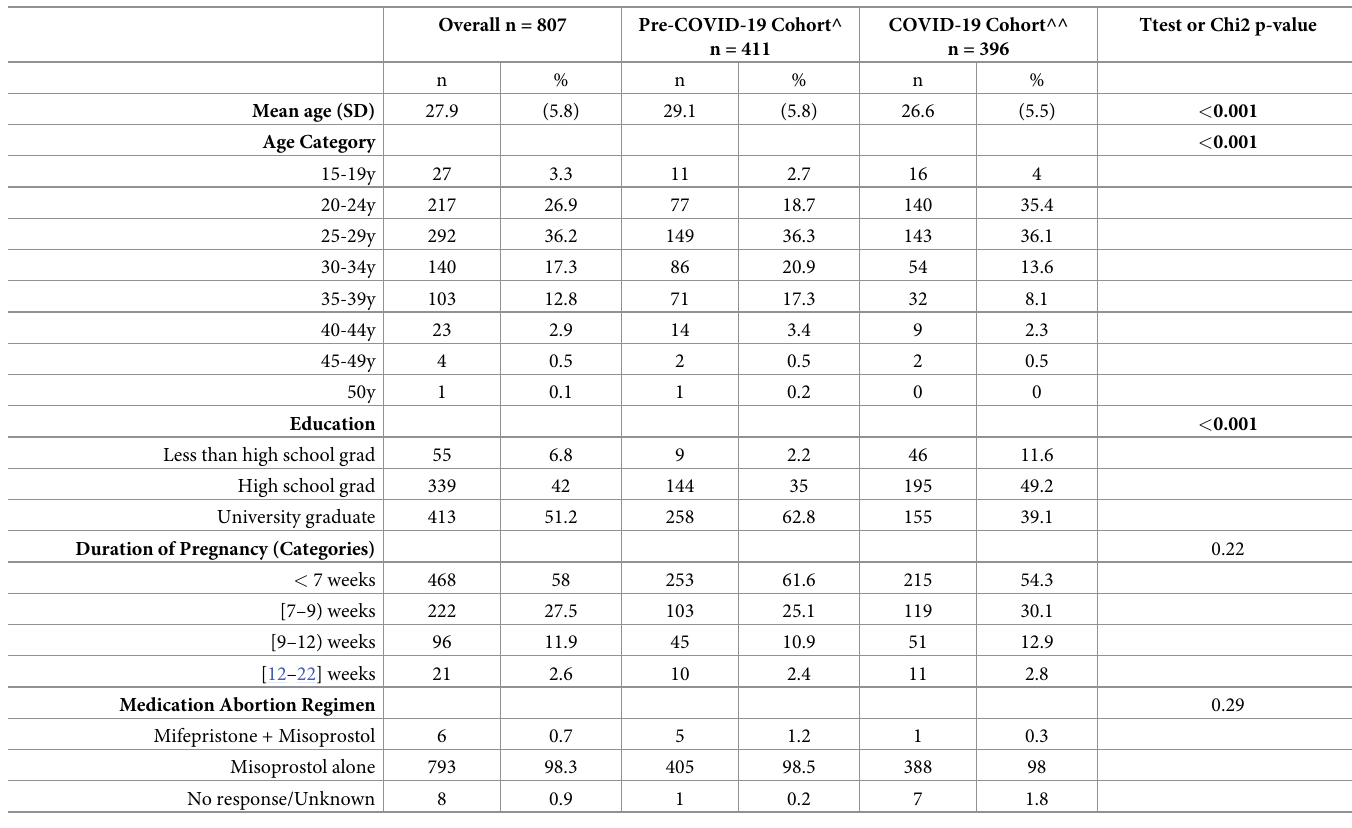
Table 1. Participant sociodemographic and pregnancy characteristics among 807 callers to a safe abortion hotline in Nigeria between October 2019 and September